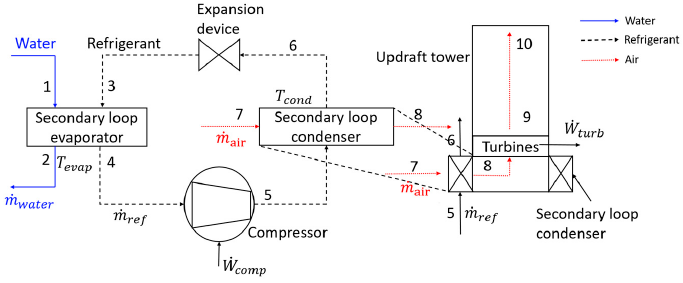
Figure 5. Coupled system model schematic drawing and key input and output variables.